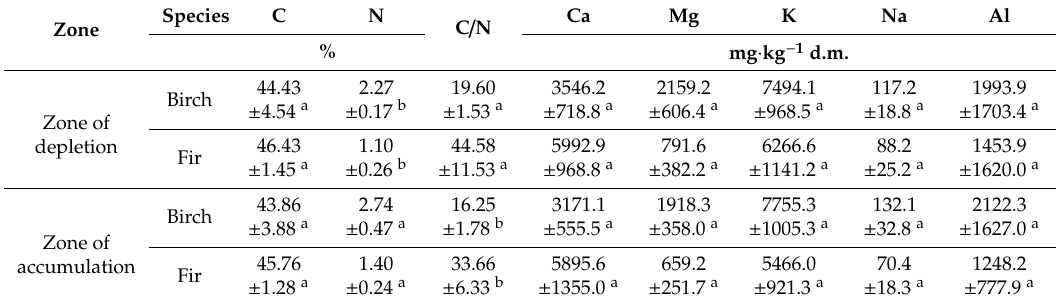
Table 4. Macronutrients in the leaves of birch and needles of fir growing in di ff erent landslide zones.